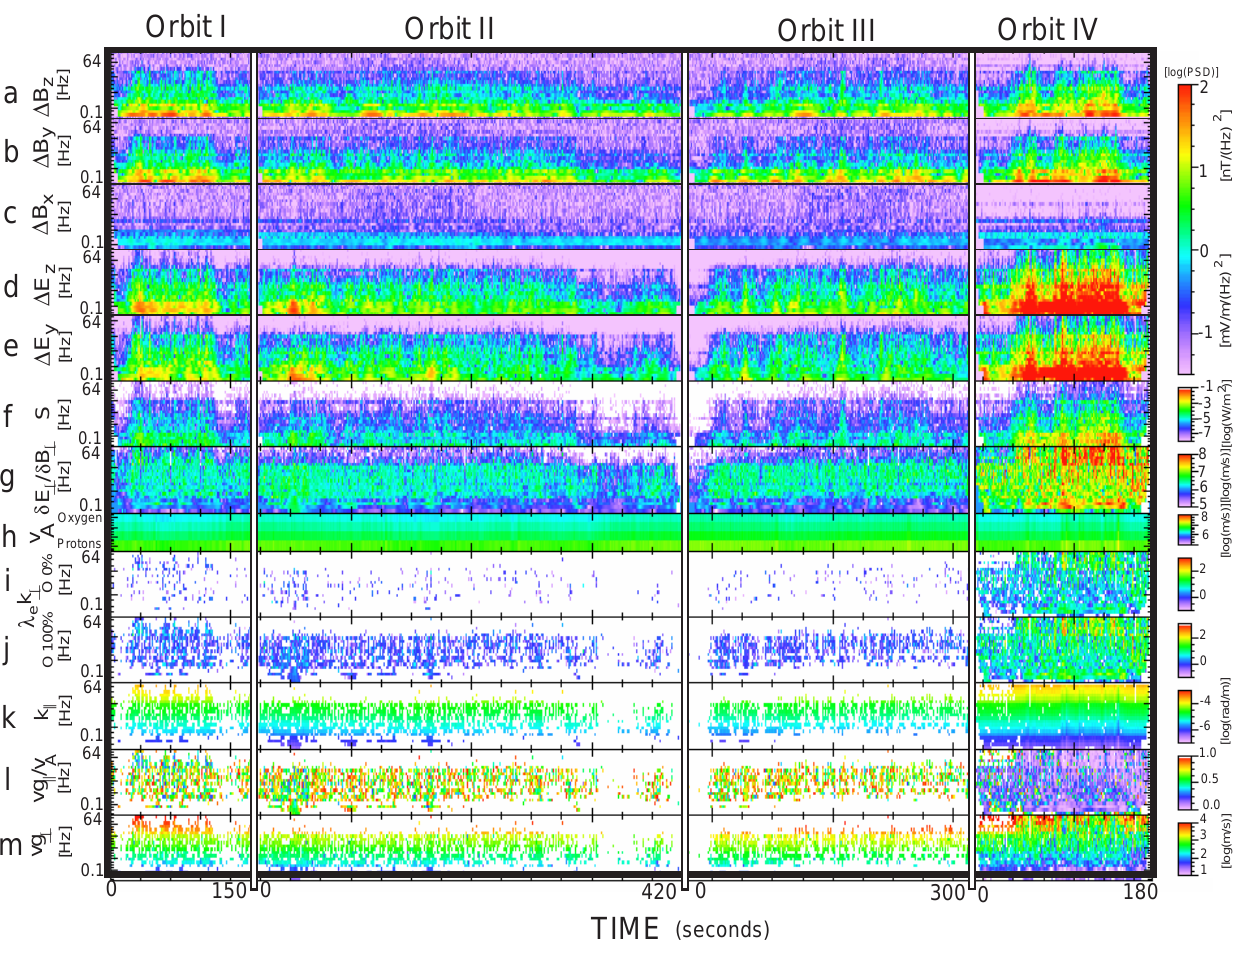
Fig. 3. More detailed ELF wave characteristics for the four orbits presented in Fig. 1. Panels from the top are, respectively; (a) to (e) the power spectral densities (PSDs) for the three magnetic field components and the two perpendicular electric field components; (f) the magnitude of the Poynting flux ( S ); (g) δE ⊥ / δB ⊥ ; (h) the Alfv´en speed ( v A ) for four different plasma compositions; (i) to (j) the value of λ e k ⊥ for a pure oxygen and a pure hydrogen plasma respectively; (k) the parallel wave vector ( k k ); (l) the parallel group velocity of inertial Alfv´en waves as a fraction of the local Alfv´en speed; (m) the perpendicular group velocity of inertial Alfv´en waves. See the text for more